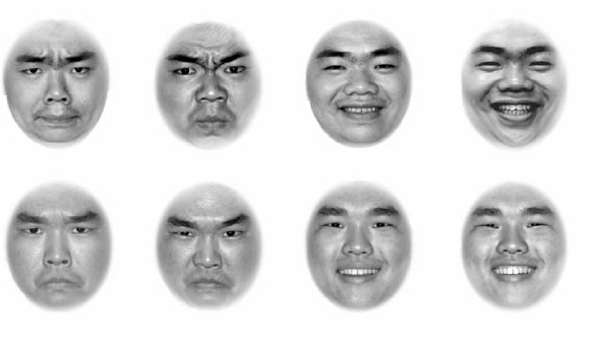
FIGURE 2 | Eight face photos used in Experiment 2. The top row of the four photos comes from Model C, and the bottom row of the four photos comes from Model D. In both the top and bottom rows, the first two photos show angry expressions, with a small difference in emotional intensity between them, and the last two photos show happy expressions, also with a small difference in emotional intensity between them.The discriminability of expression was high, with a RT of 440 ms. and the discriminability of identity was low, with a RT of 519